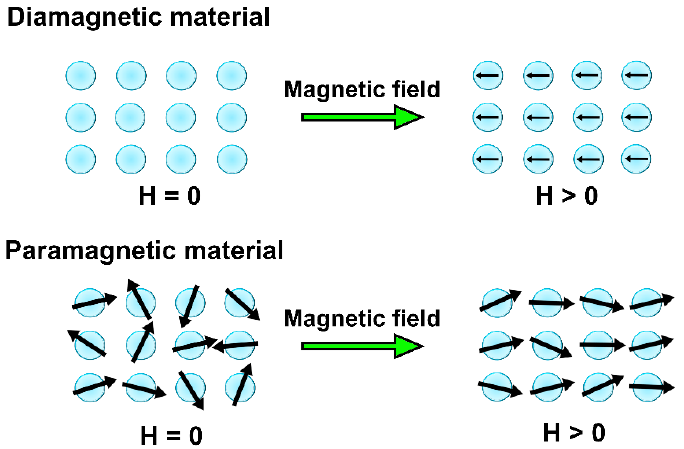
Figure 1. Simple sketch of the atomic magnetic moment configurations in diamagnetic and paramag- netic materials before and after the application of an external magnetic field (